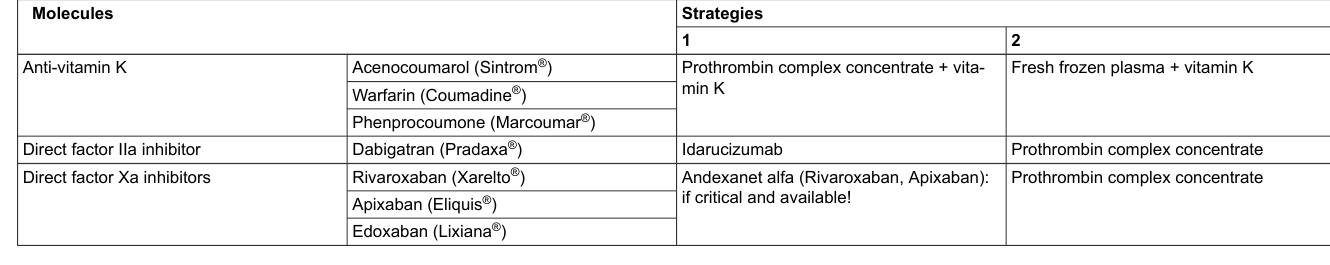
Table 4: Management strategy for major bleeding according to anticoagulant. Molecules Anti-vitamin